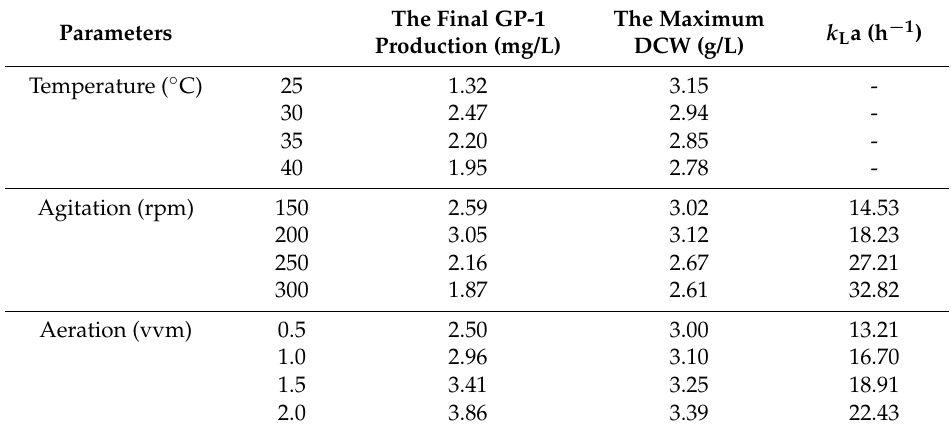
Table 1. The final GP-1 production, the maximum DCW and k L a under different temperatures, agitation speeds and aeration rates in a 5 L fermentor.